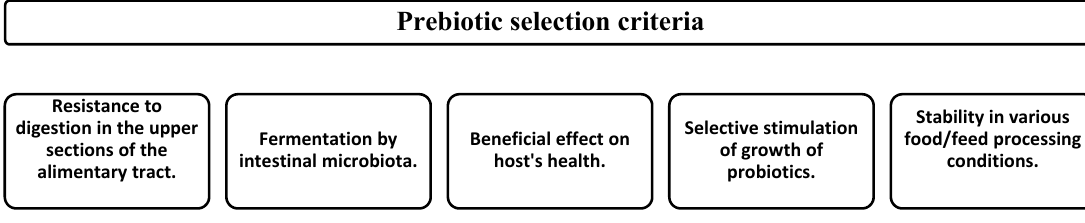
Figure 2. Requirements for potential prebiotics [132,138].